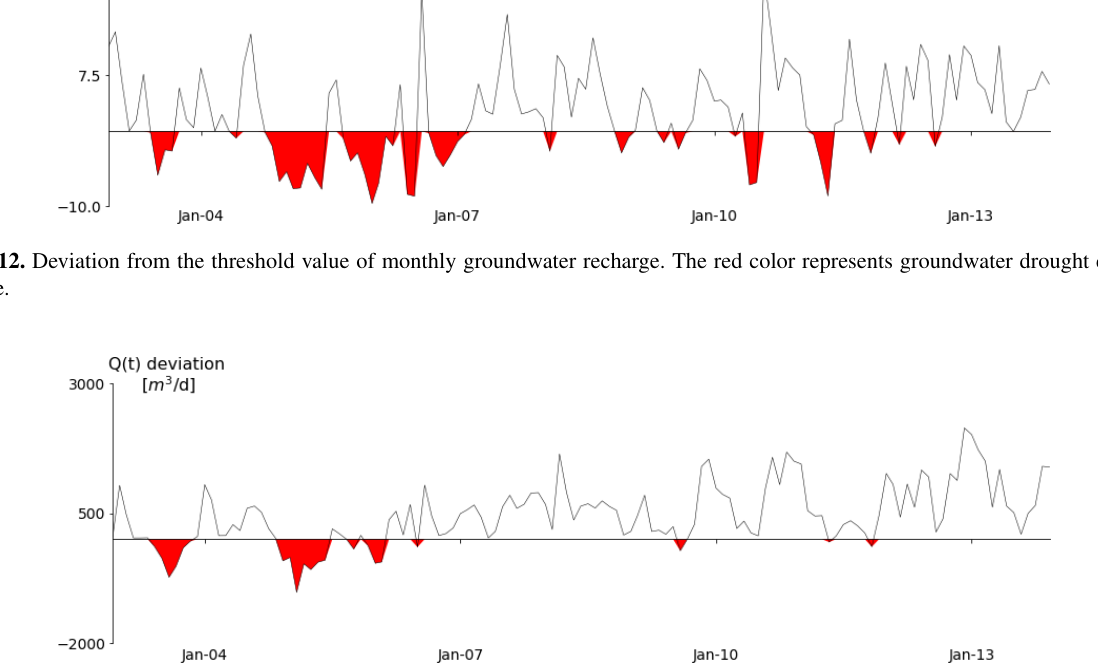
Figure 13. Deviation from the threshold value of monthly groundwater discharge to wetland. The red color represents groundwater drought events on discharge.